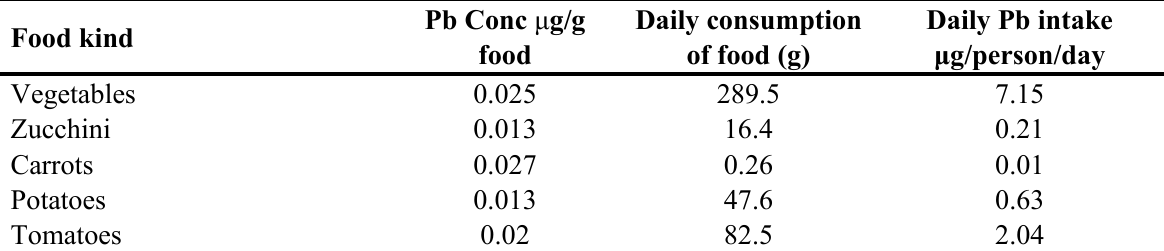
Table 3. Lead daily intake in correlation with the KSA food balance given by the